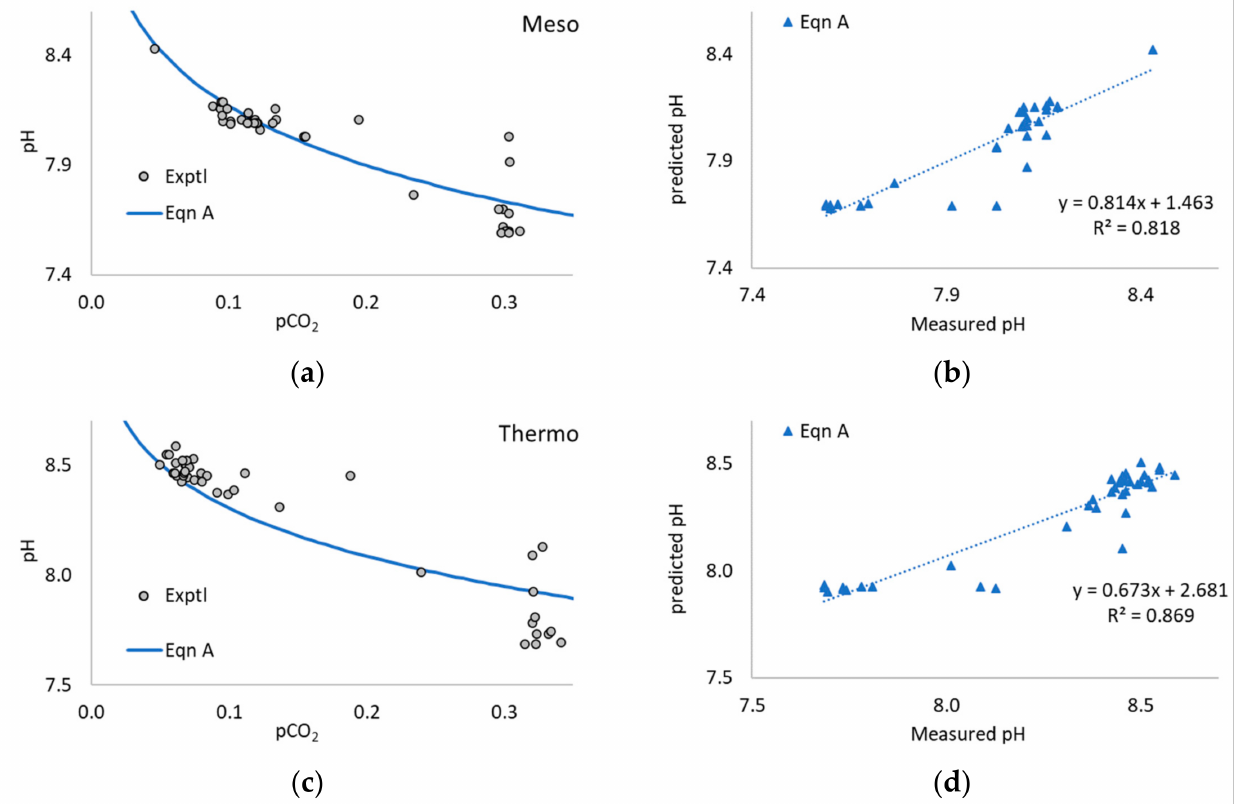
Figure A2. Experimental pCO 2 and pH values and predicted pH from Equation A for 2-stage mesophilic ( a , b ) and thermophilic ( c , d ) CO 2 biomethanisation of cattle manure associated with Bassani et al. [32]. See Table S15 for operating conditions and average results for each